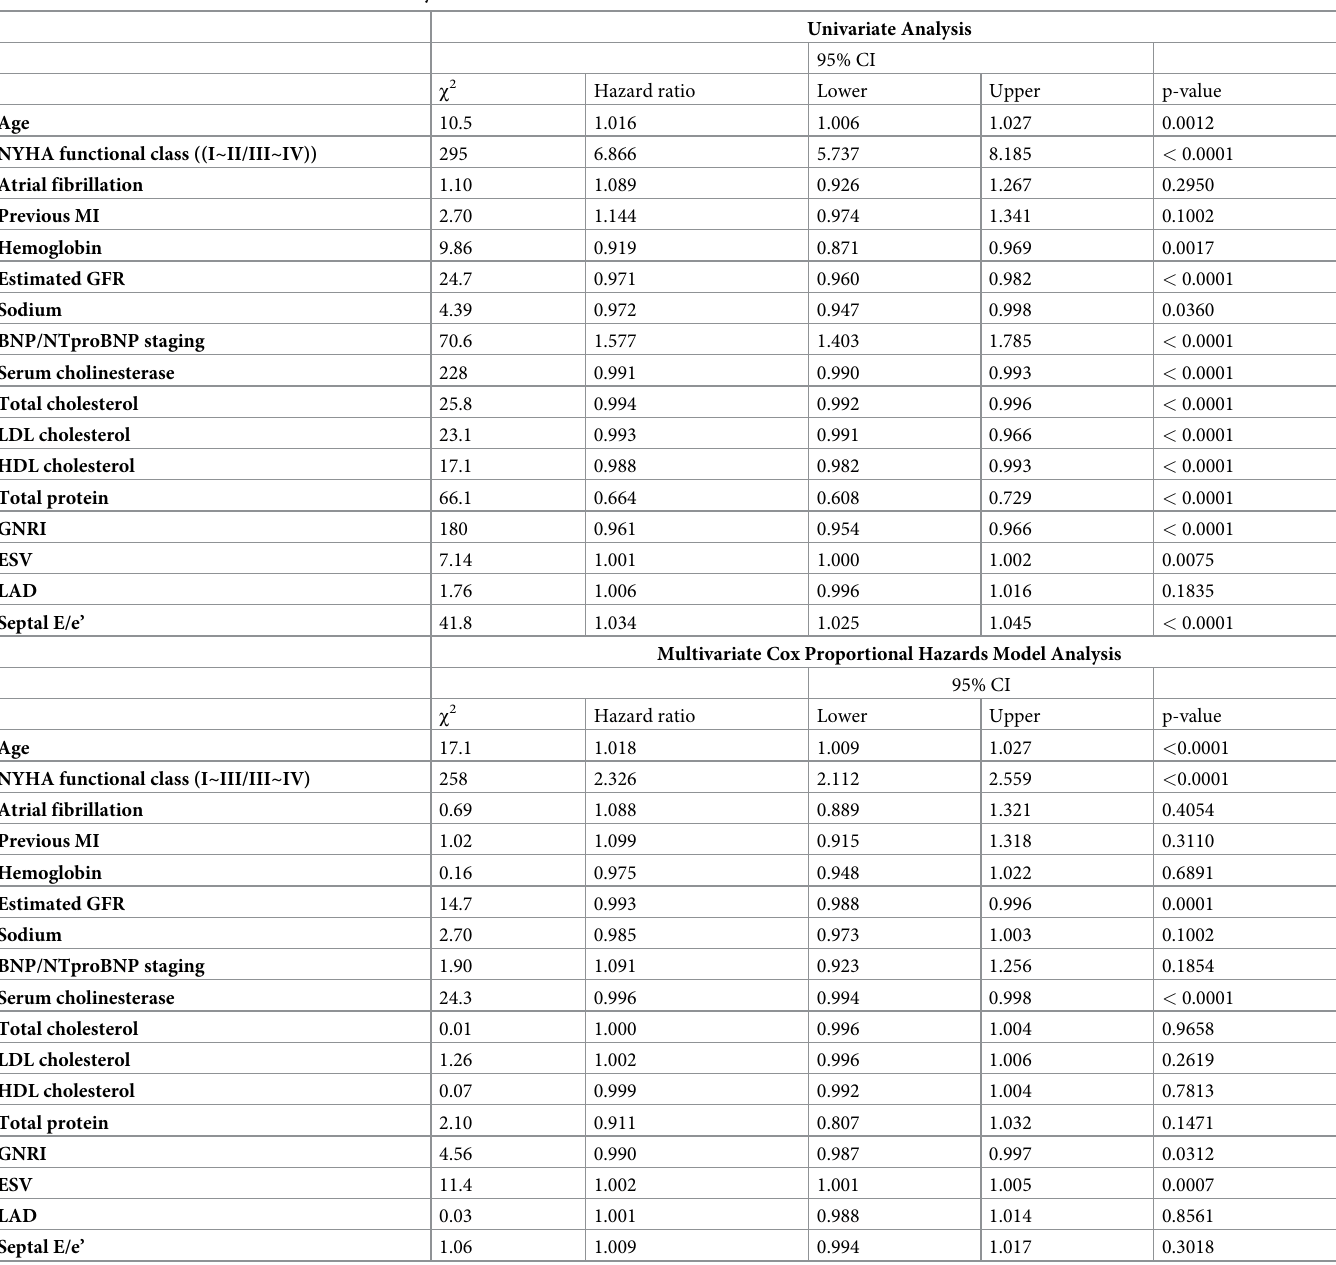
Table 2. Results of univariate and multivariate